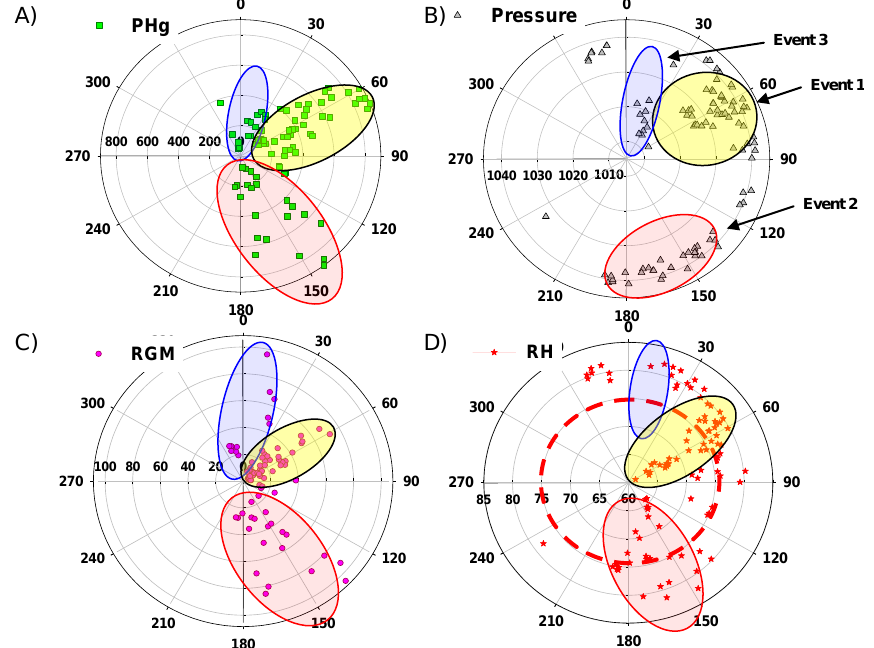
Fig. 4. Wind roses of (A) PHg concentration data (pgm − 3 ) , (B) air pressure (mB), (C) RGM concentration data (pgm − 3 ) and (D) percent relative humidity (%) for the data from 14 to 27 March 2009 from over the sea ice. Yellow, red and blue circles represent events 1, 2 and 3,